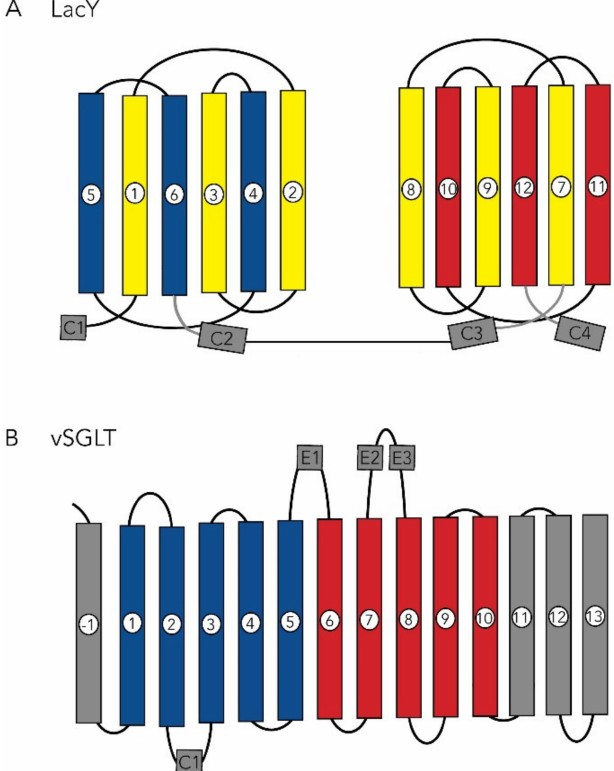
Figure 4. Topology of LacY and vSGLT . LacY shows N-terminal TM 1–6 and C-terminal TM 7–12 domains, and each domain contains a 3TM inverted repeat, a common feature of MFS transporters. The 4 short cytoplasmic helices, C1–C4, are also conserved in members of the MFS family, but there is no evidence that they regulate transport activity in LacY . vSGLT has 14 TM helices, TM-1 to TM13 and four short extramembrane helices, C1, E1, E2 and E3. In common with other APC transporters, vSGLT contains a core of 10 transmembrane helices, TM1–TM10, organized in a 5 TM inverted repeat, TM1–TM5 and TM6–TM10. The numbering of the TM helices is simply to facilitate comparison with other APC transporters (Abramson & Wright 2009).